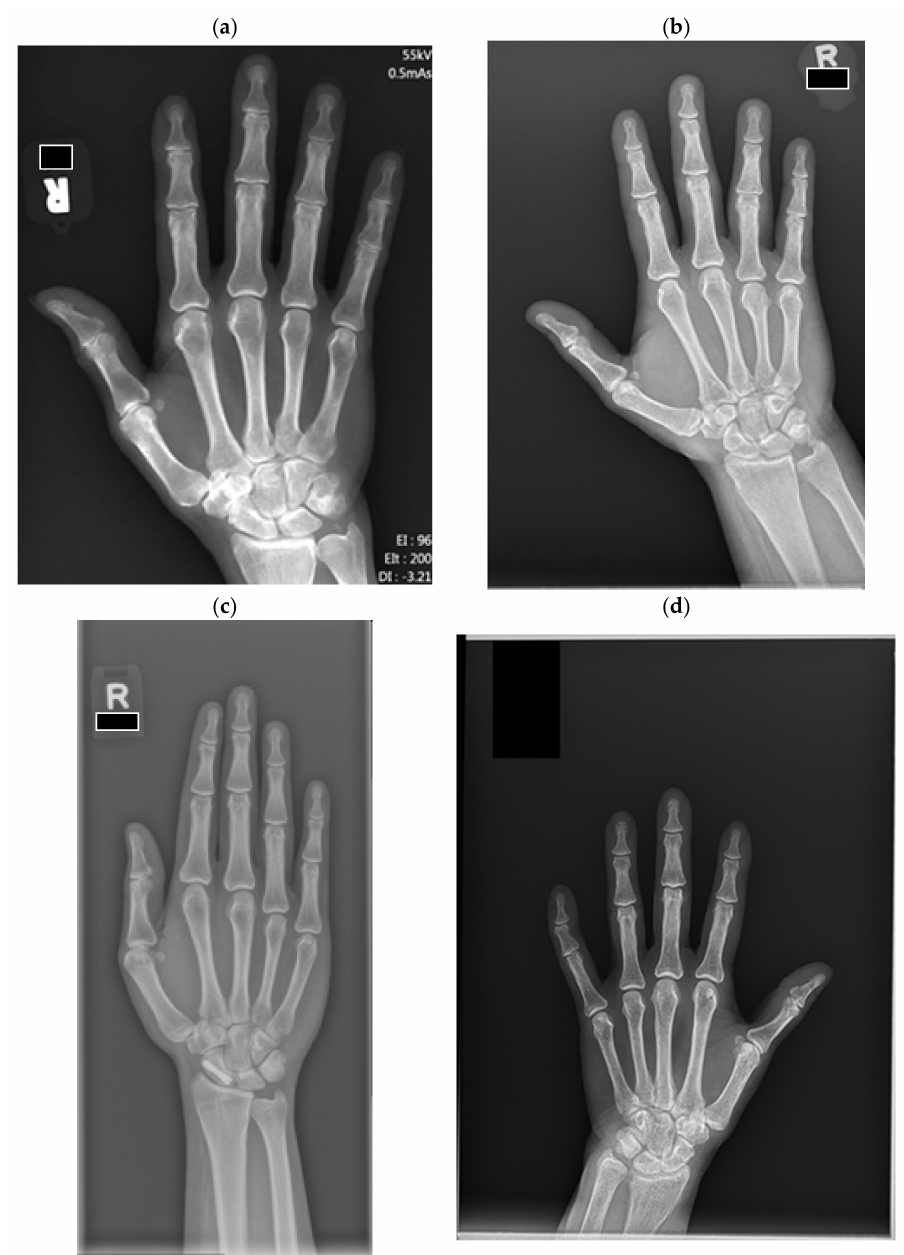
Figure 2. ( a ) Example of excellent quality, category 4 radiograph. Ideal field of view (FOV). FOV starts proximally from the metaphysis of the radius and ulna and adequately covers the most distal soft tissues of fingers. It does not have large blank spaces distally or on the sides. ( b ) Example of category 3 radiograph. Satisfactory FOV. FOV is slightly large and includes forearm proximal to radius and ulnar metaphysis, covering up to 1/3 of the forearm. There is a larger blank space distally or on the sides but measuring equal or less than the height of the long finger distal phalanx. It does not limit diagnostic accuracy and does not require zooming. ( c ) Example of category 2 radiograph. Somewhat limited. Large blank space distally or on the sides. Blank space at the top measuring larger than the height of the long finger distal phalanx and up to two distal phalangeal heights. FOV may extend more proximal to the radius and ulnar metaphysis, covering 1/3 to 1/2 of the forearm. It does not limit diagnostic accuracy, but may require zooming for evaluation. ( d ) Example of poor quality, category 1 radiograph—Substantially limited FOV. Large blank spaces distally or on the sides. The blank space at the top measures larger than the double of height of the long finger distal phalanx. FOV may extend more proximal to the radius and ulnar metaphysis, covering more than 1/2 of the forearm. It limits diagnostic accuracy and requires zooming for